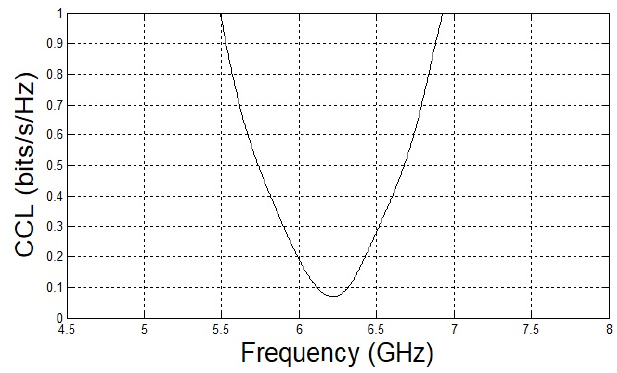
FIGURE 9: CCL of the MIMO antenna system